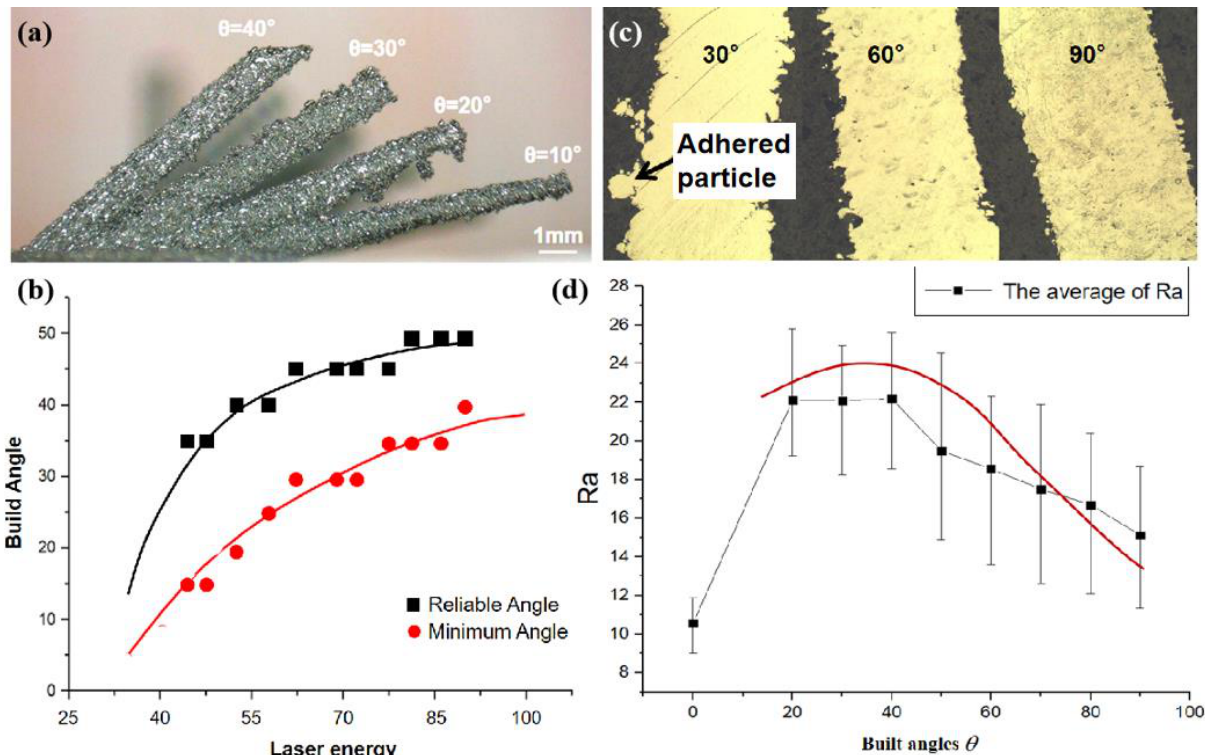
Figure 7. The profiles ( a ) and cross-sections ( b ) of as-printed micro-rods, the relationship between as-built angle and laser energy ( c ), and the relationship between as-built angle and surface roughness ( d ). For micro-rods, without adding a support structure, there is a critical angle of manu- facturing called the self-supporting angle in the literature [21]. The micro-rod cannot be formed when the inclination angle is smaller than the critical